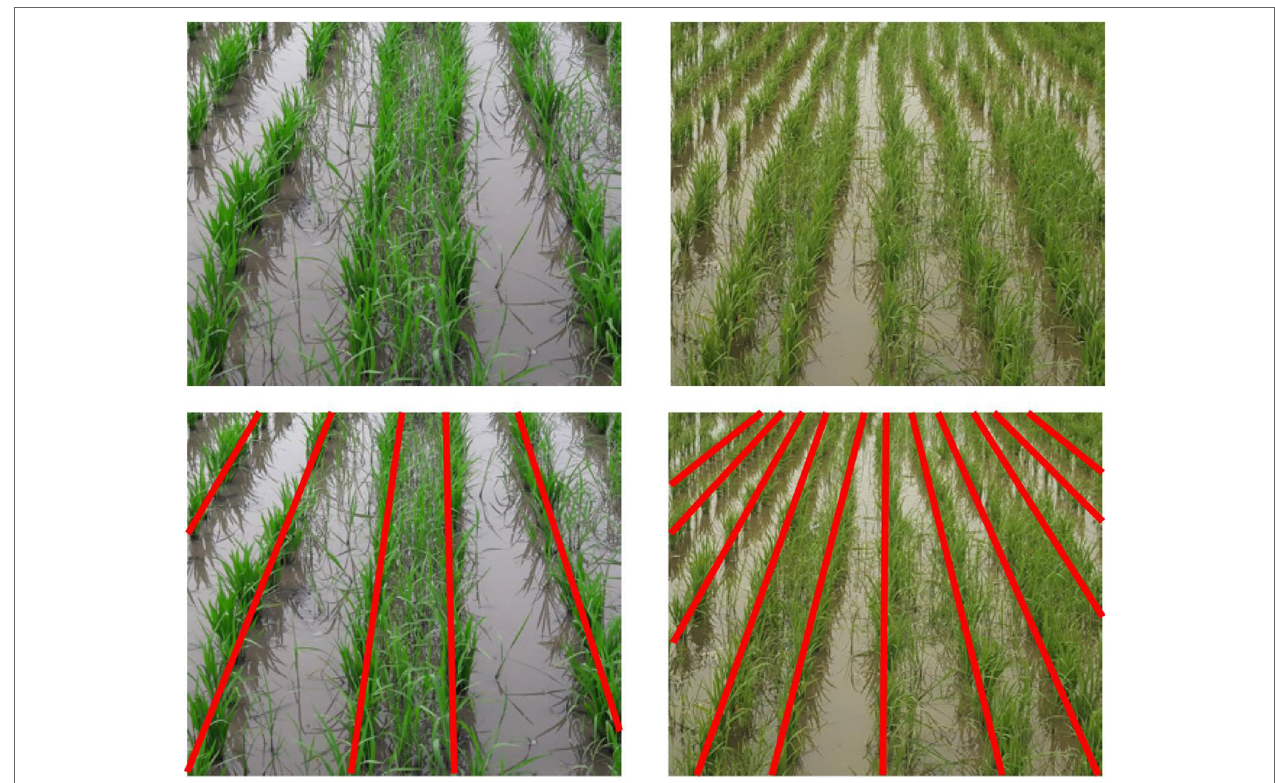
FIGURE 2 | Semantic graphics: (top) images of row-transplanted paddy field. (bottom) Manually marked semantic graphics representing the rows of paddy is superimposed on the original images. Even at places where the paddy lines are rendered indistinguishable due to the heavy presence of weeds, humans can easily figure out the actual lines and represent those using semantic graphics. (Best viewed in